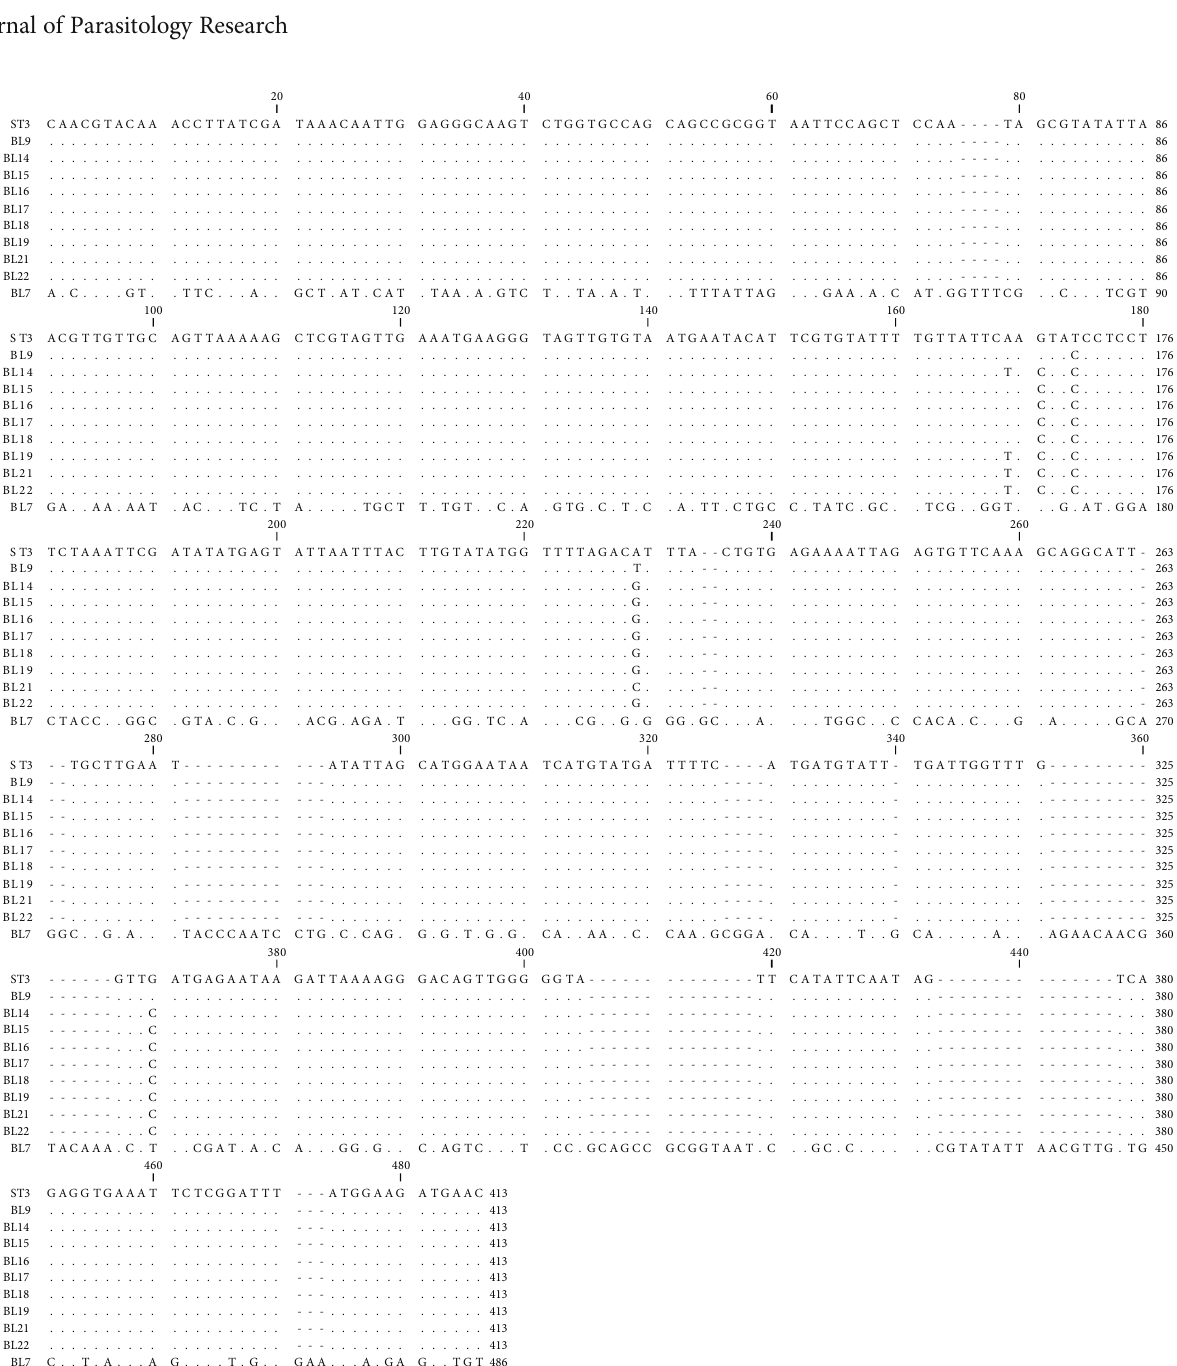
Figure 4: Alignment nucleotides of accession number MG254568 (BL7) with the ST3